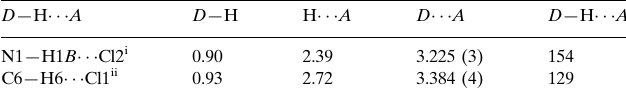
Hydrogen-bond geometry (A˚ , (cid:2)